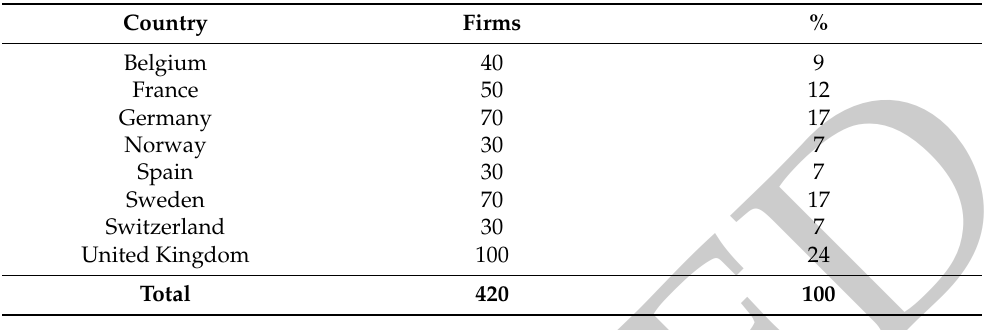
Table 1. Sample distribution across countries.